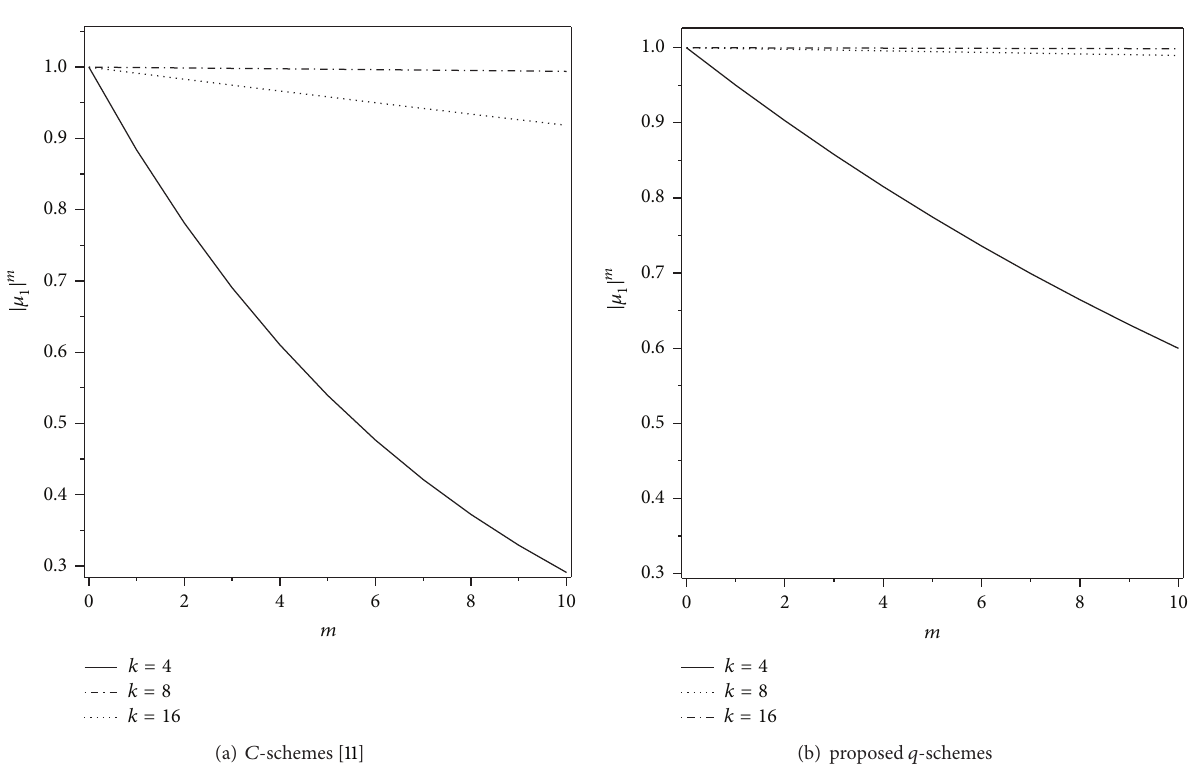
Figure 3: Rate of shrinkage plotted for the 𝐶 -schemes [11] and proposed 𝑞 -schemes against the number of smoothing stages 𝑚 , for polygons having 4, 8, and 16